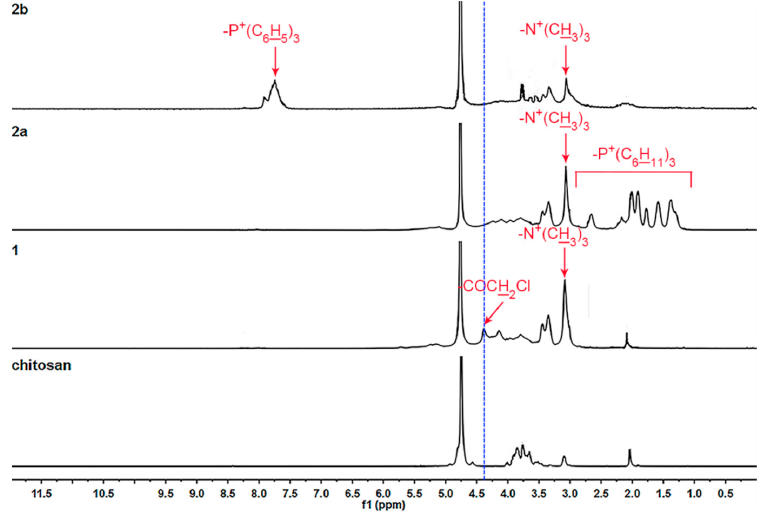
Figure 2. 1 H-NMR spectra of chitosan and chitosan derivatives.